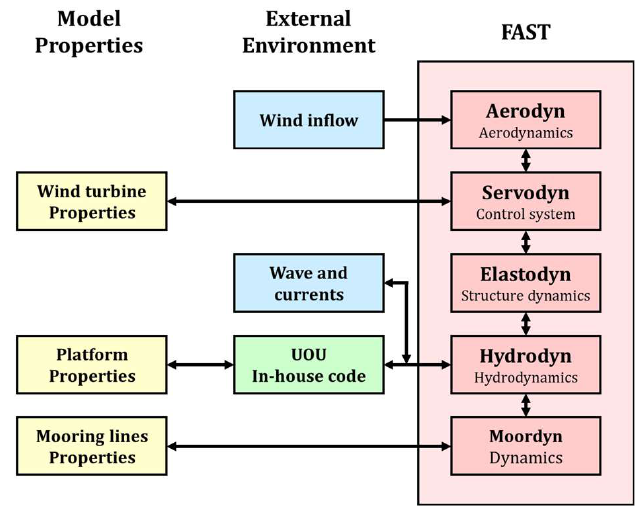
Figure 8. Modeling for the hydrodynamic analysis.